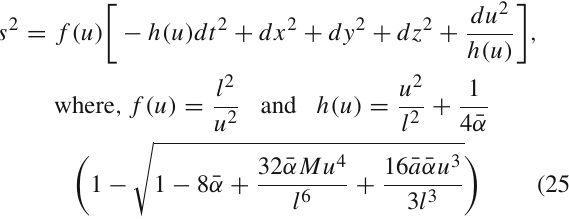
Fig. 8 Landau function vs. ¯ r for four different temperatures: ¯ T 0 = 0 . 42 (red) , ¯ T 1 = 0 . 44 (green) , ¯ T c = 0 . 4545 (blue) ¯ T c 1 = 0 . 4568 (pink) ; ¯ T < ¯ T < ¯ T < ¯ T ¯ a = 0 . 1 and ¯ α = 0 . 001, b is for ¯ a = 0 . 1, ¯ α = 0 . 01and l = c c 1 a 0 1